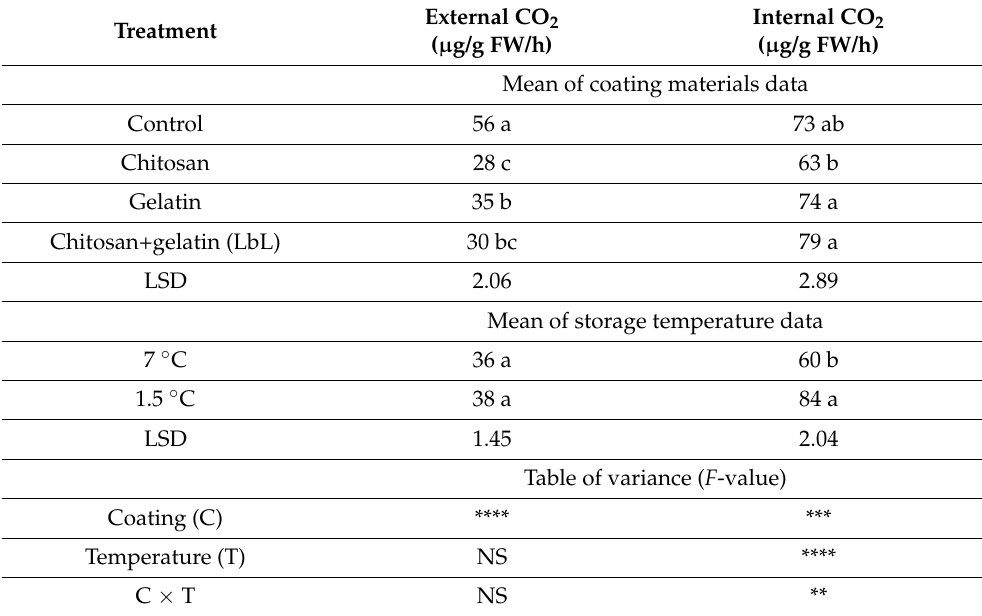
Figure 1. The effects of the different coatings and storage temperatures on external and internal CO 2 production of pepper fruits after 21 d at 7 or 1.5 ◦ C, followed by 3 d at 21 ◦ C. Mean data from three harvests are presented, with 5 replications for each harvest ± S.E. Table 4. External and internal CO 2 as means of coating materials and storage temperatures, and table of variance.